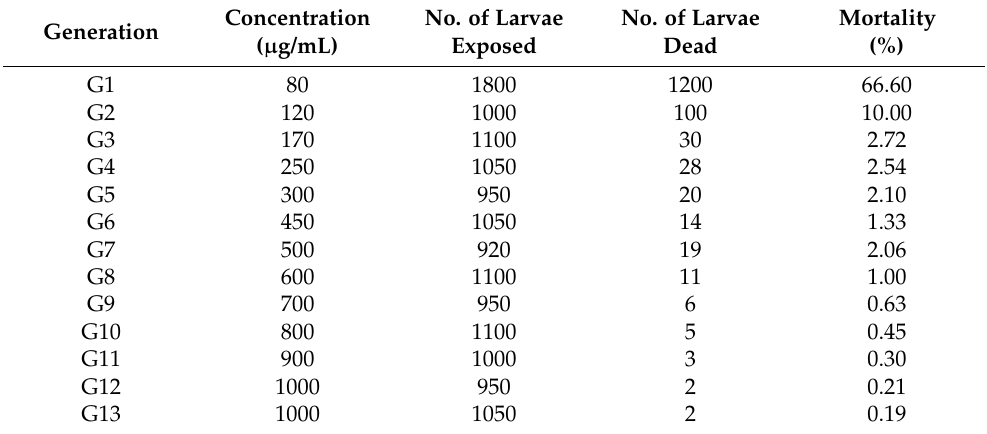
Table 2. History of generations selected with flubendiamide and percent mortalities of Tuta absoluta .